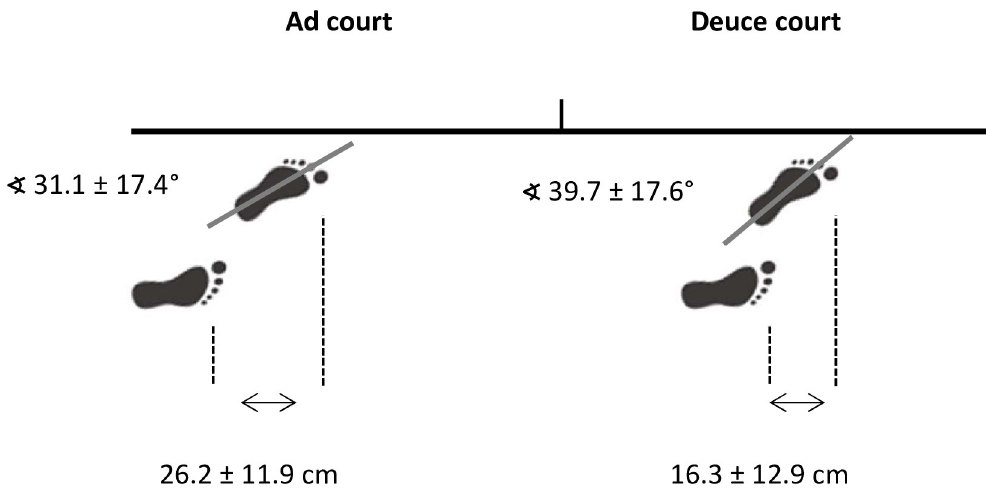
Fig 1. Mean foot position on ad and deuce court side immediately before ball toss.